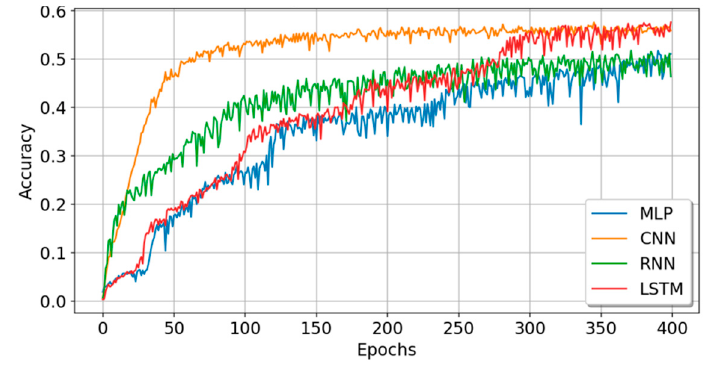
Figure 16. Loss values during training of the four